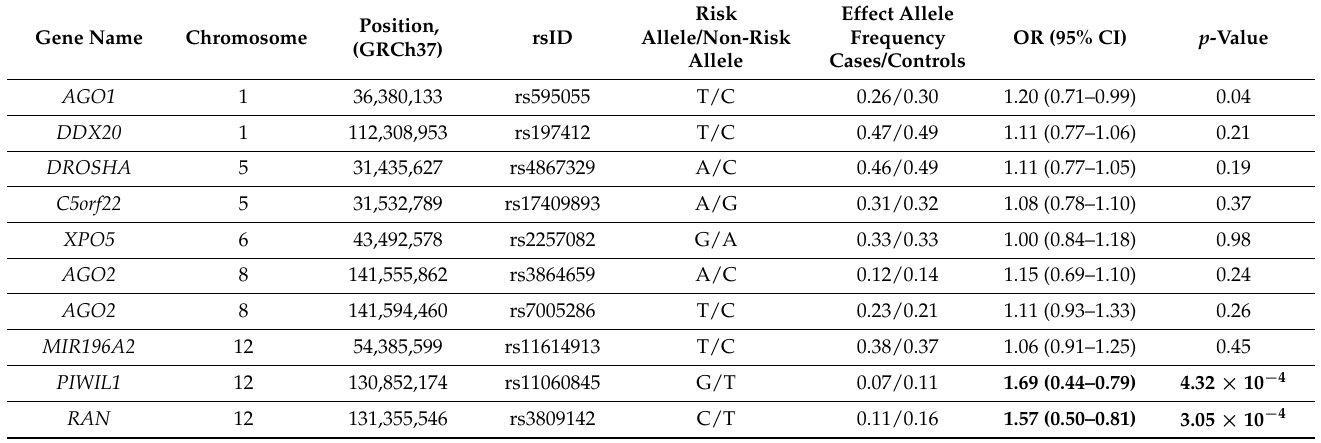
Table 2. Association between reduced set of 21 DNA variants in miRNA biogenesis genes and ccRCC in Volga-Ural